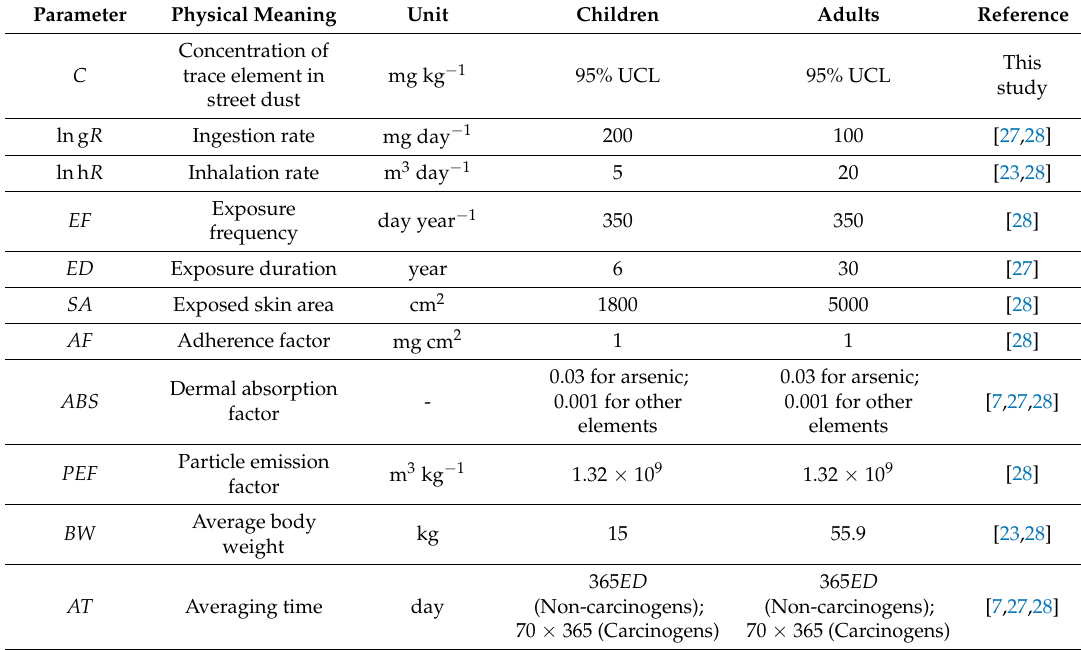
Table 1. Values and factors used for non-carcinogenic hazard health risk assessment.